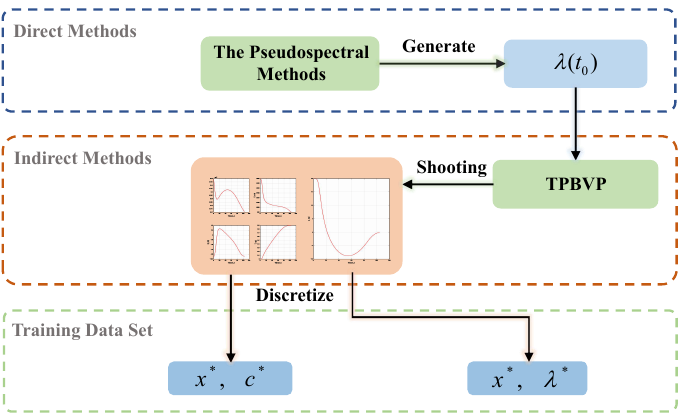
Figure 1. Training dataset generation